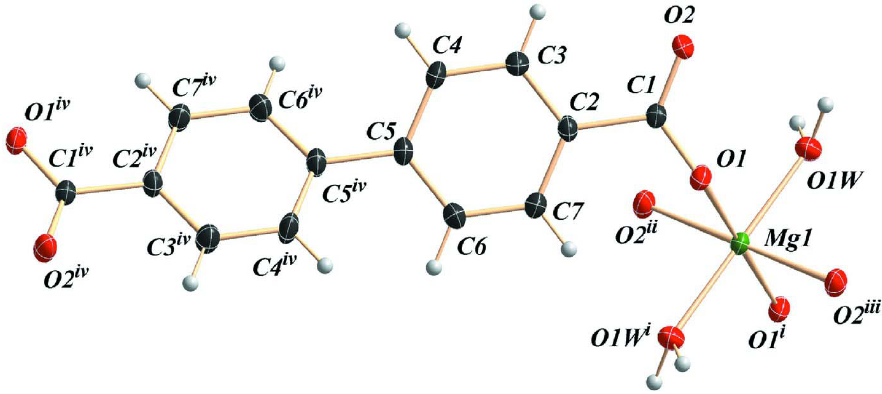
Crystal structure of the title compound with labeling and displacement ellipsoids drawn at the 50% probability level. [symmetry codes: (i) - x + 2,- y + 1,- z ; (ii) - x + 3/2, y - 1/2, z ; (iii) x + 1/2,- y + 3/2,- z ; (iv) - x + 2, y ,- z +